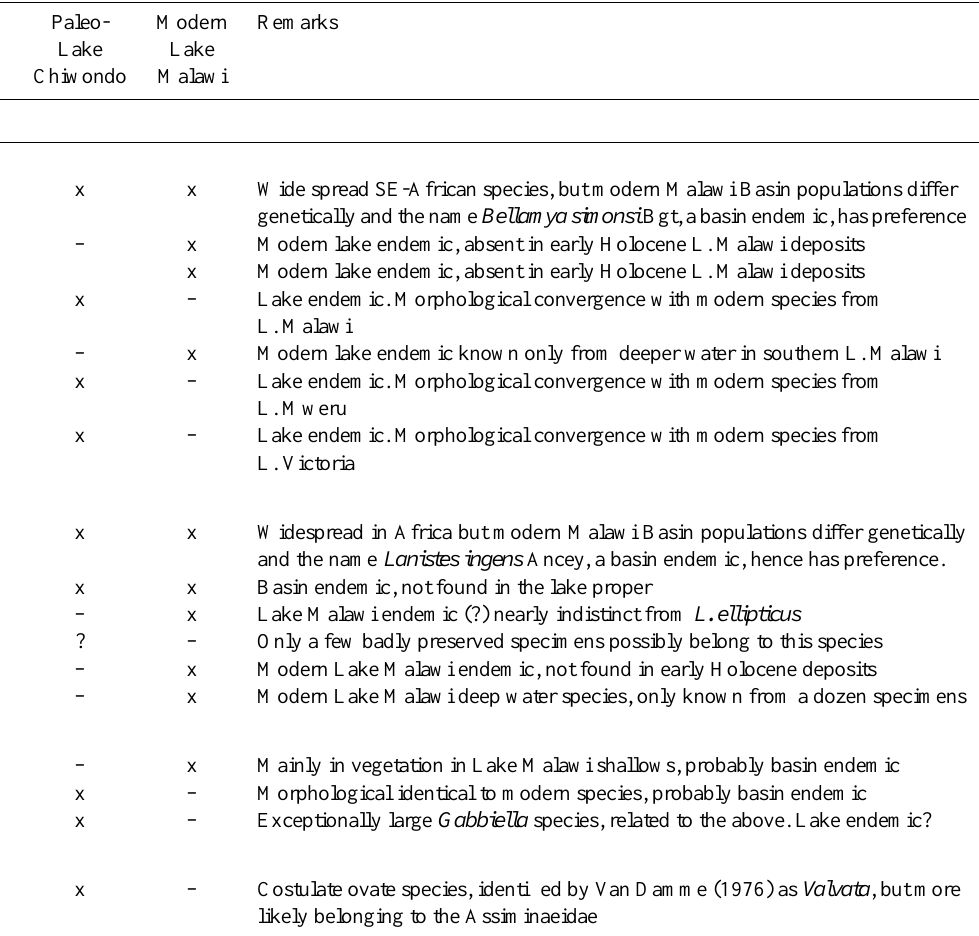
Table 1. Freshwater molluscs from terminal Pliocene–early Pleistocene Paleo-Lake Chiwondo and modern Lake Malawi. Taxonomy and range of modern species according to Brown (1994) and Graf and Cummings (2007) except when mentioned